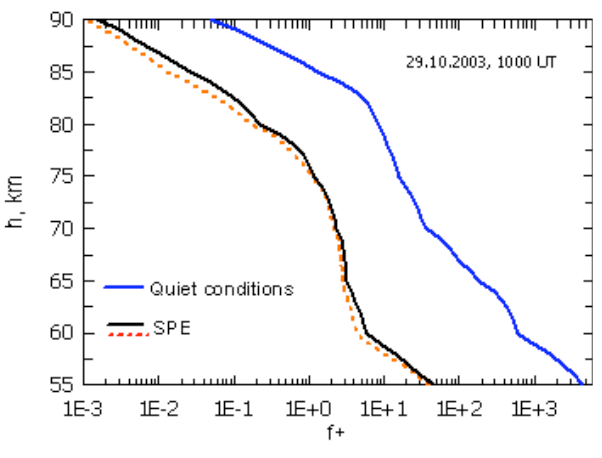
Fig. 8a. f + profiles calculated for quiet conditions (blue curve) using the O, O 3 and NO profiles 1–3 in Fig. 1 and for the SPE on 29 October 2003 at 10:00UT using profiles 4–6 in Fig. 1 (black curve) and 1–3 in Fig. 1 (red dashed curve).